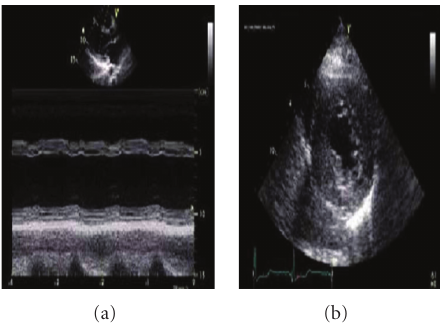
Figure 1: (a) Parasternal long-axis view showing the left ventricular dilatation and advanced global hypokinesis. (b) Parasternal short axis view showing the septal and posterior wall hypertrophy.